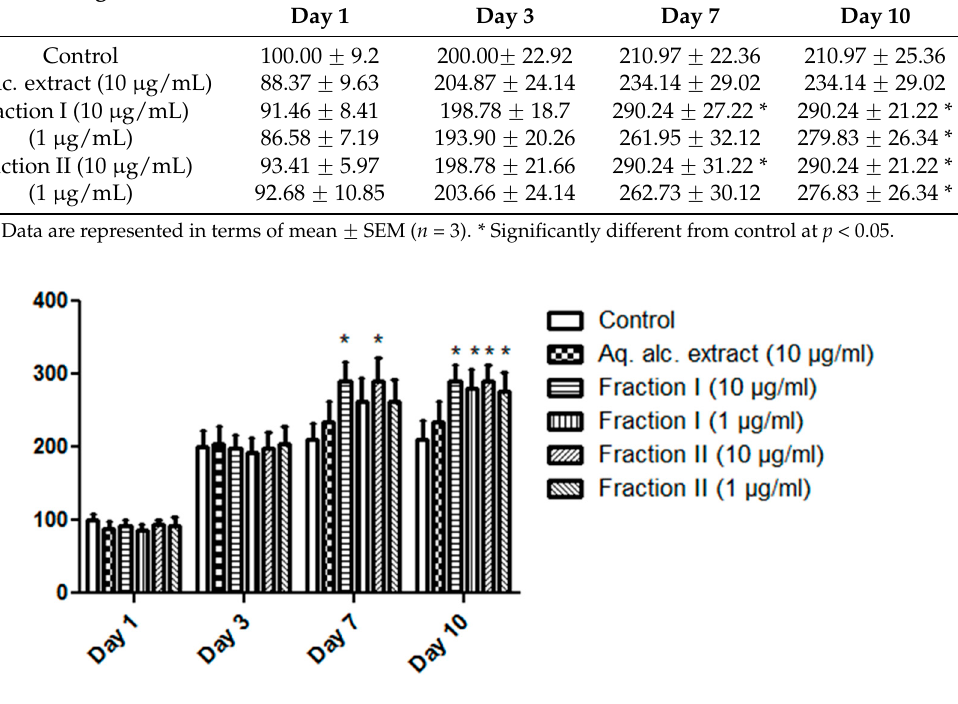
Figure 4. Effect of Erythrina crista-galli extract and fractions on the rate of proliferation of the MCF-7 cell line. * Significantly different from corresponding control at p < 0.05.